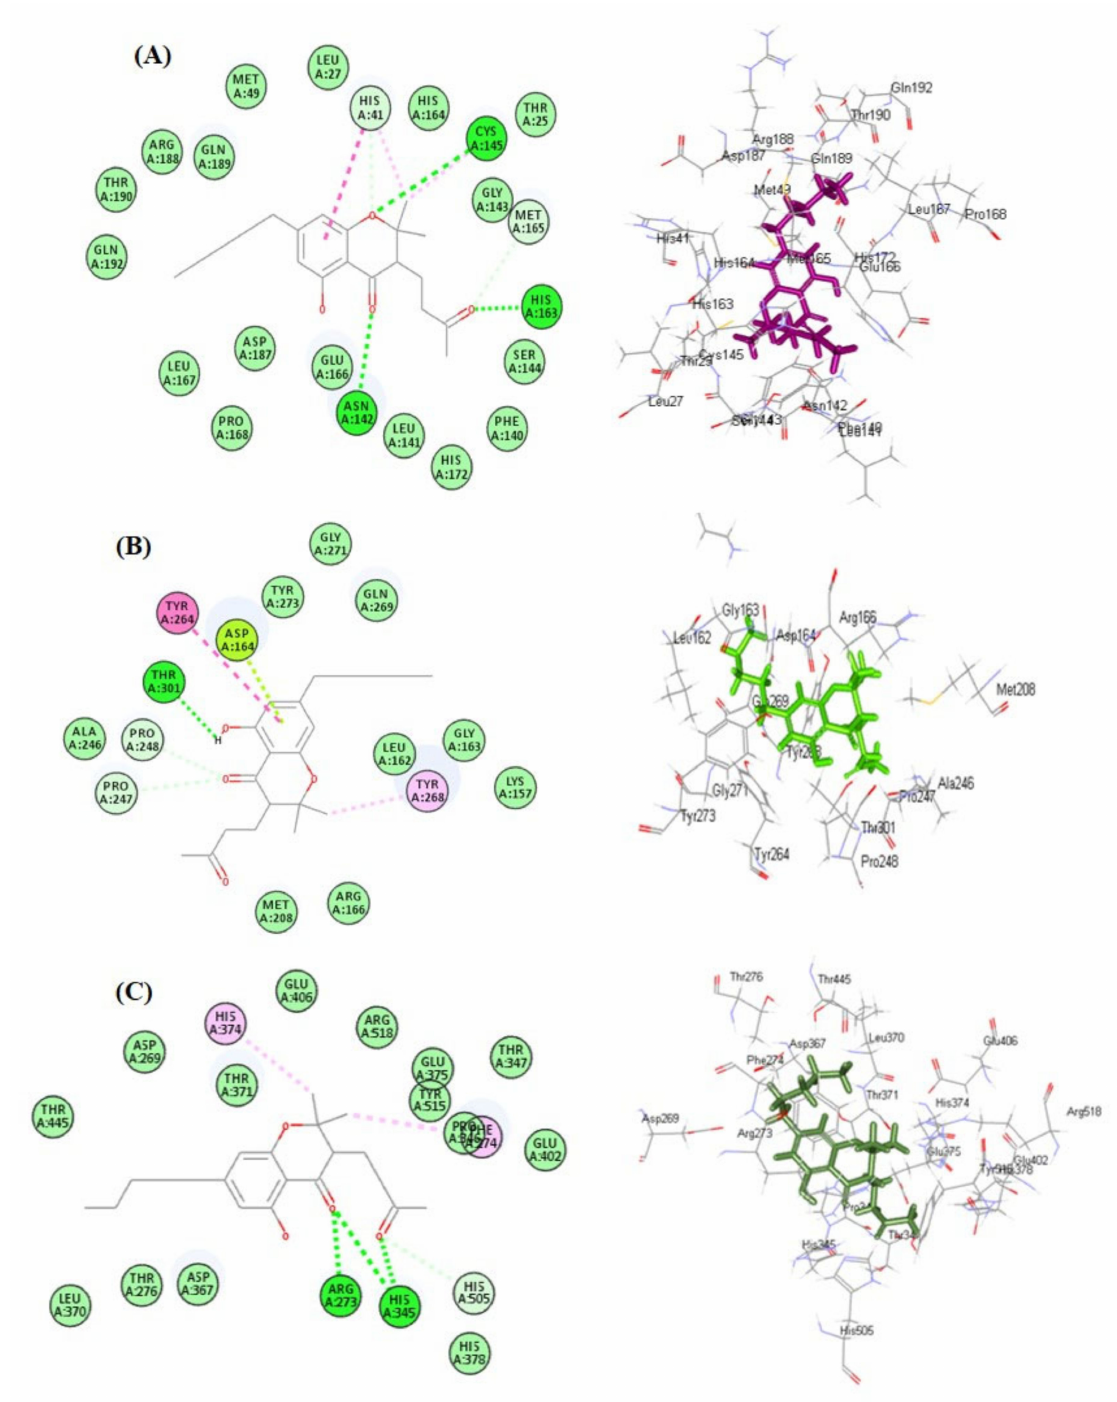
Figure 3. 2D and 3D binding of cannabichromanon within the active sites of SARS-CoV-2 M Pro ( A ); SARS-CoV-2 PL pro ( B ) and ACE2 ( C